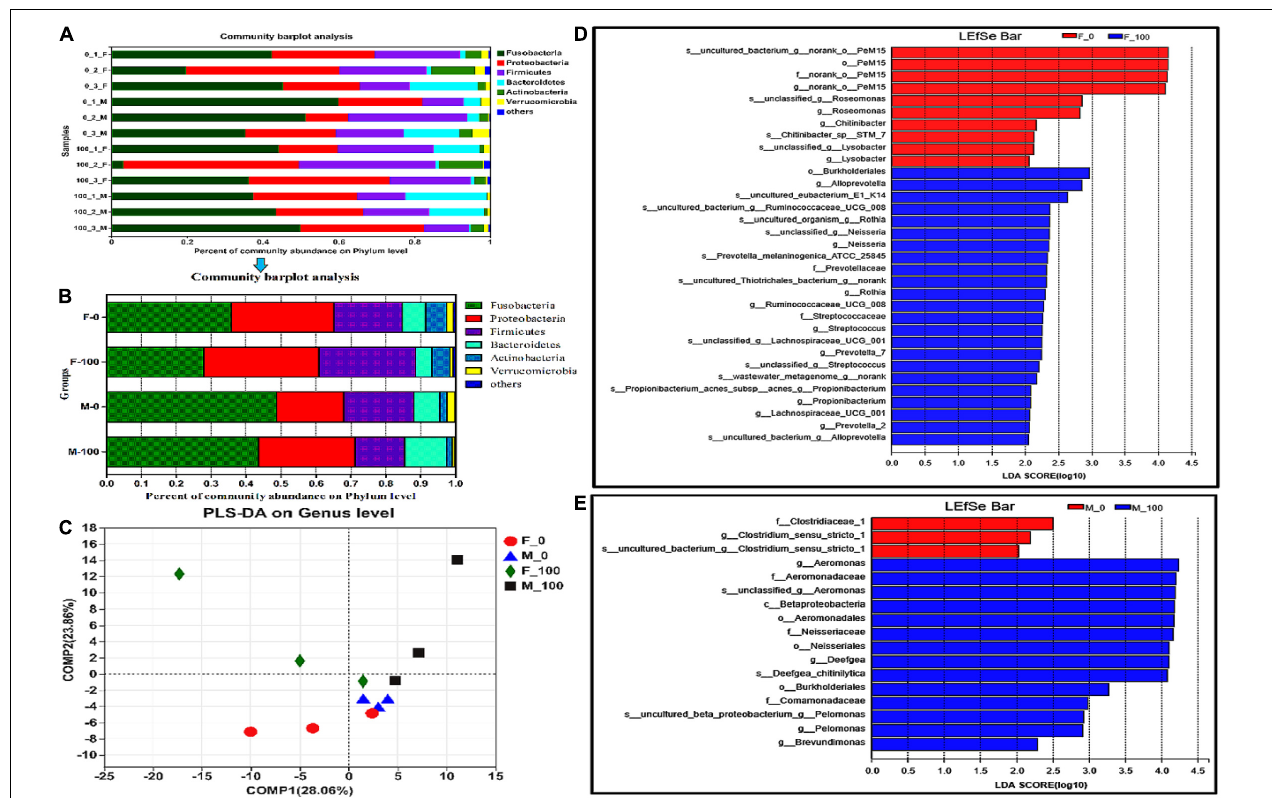
FIGURE 2 | The analysis of zebrafish intestinal microbiota community at levels from phylum to species. The composition of intestinal microbiota at the phylum level (distribution in all samples A and averaged in groups B ), and PLS-DA analysis (C) in zebrafish after DEHP exposure, and the average value of three replicates ( n = 3) for female and male samples in each group was calculated, and the value of phylogenetic groups accounting for < 0.01 was summarized as “others.” The LEfSe analysis of intestinal microbiota showed the major affected bacteria in female (D) and male (E) zebrafish from phylum to species level, with the LDA value > 2 and all-against-all (stricter)